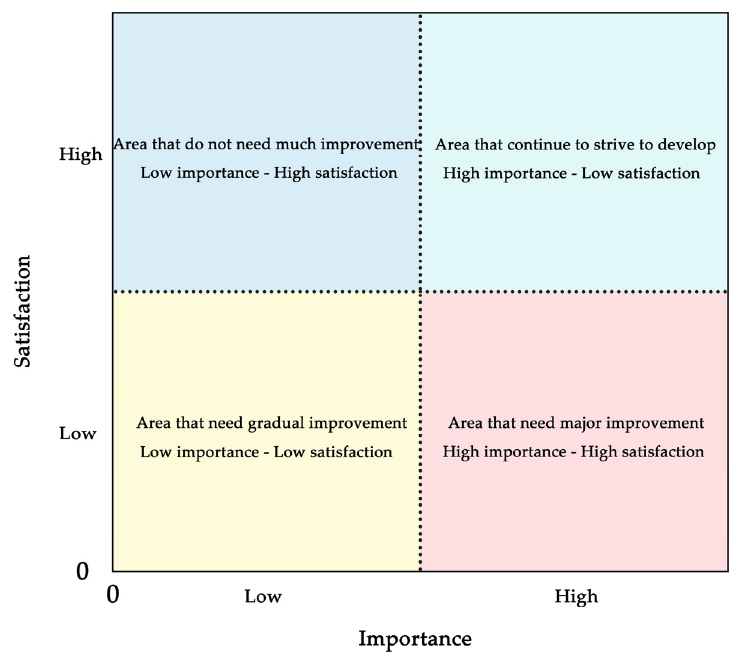
Figure 3. IPA evaluation model diagram with four